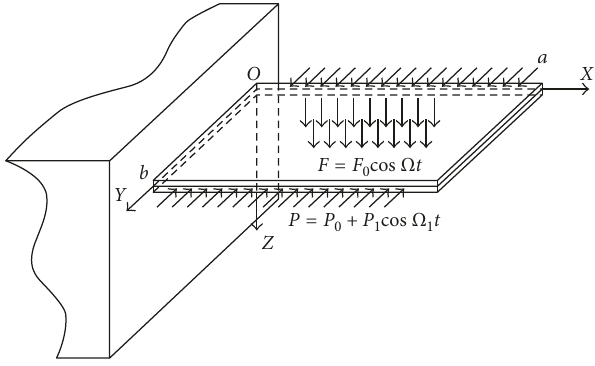
Figure 1: The model of cantilever honeycomb sandwich